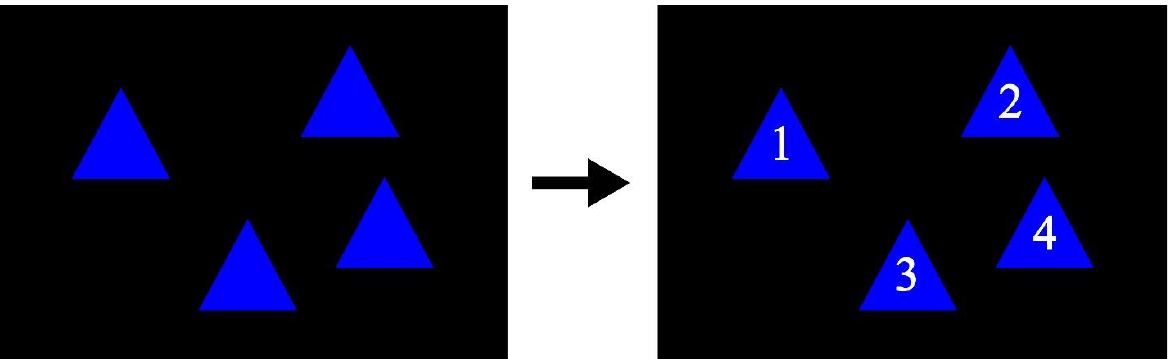
Example Trial for the Spatial Working Memory